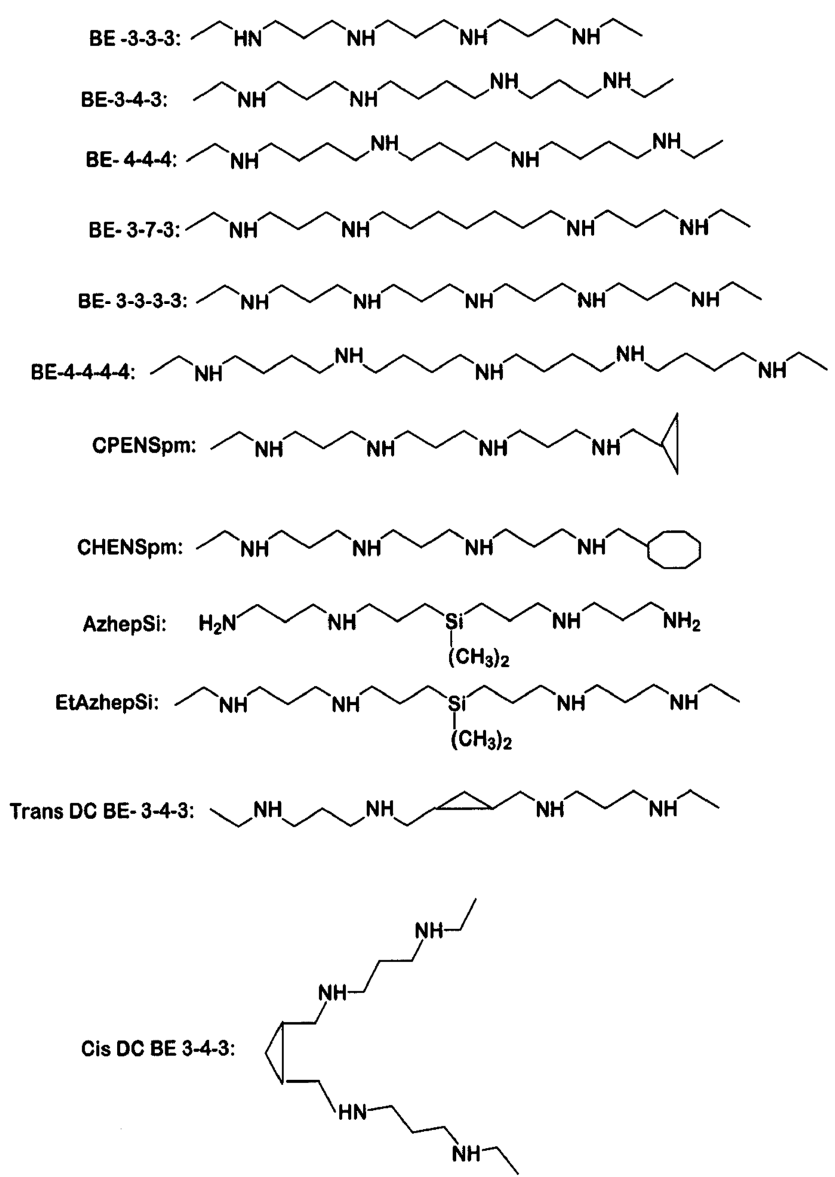
Figure 2. Chemical structures of polyamine analogs. Abbreviations are as follows; BE-3-3-3, N 1 , N 11 -bis(ethyl)norspermine (BENSpm or DENSpm); BE-3-4-3, N 1 , N 12 -bis(ethyl)spermine; BE-4-4-4, N 1 , N 14 -bis(ethyl)homospermine; BE-3-7-3, N 1 , N 15 -bis-[3-(ethylamino)propyl]-1-17-heptane diamine; BE-3-3-3-3, 1,15-bis(ethylamino)-4,8,12-triazapentadecane; BE-4-4-4-4, 1,19-bis(ethylamino)-5,10,15- triazanonadecane; CPENSpm, N 1 -ethyl- N 11 -(cyclopropyl)methyl-4,8-diazaundecane; CHENSpm, N 1 -ethyl- N 11 -(cycloheptyl)methyl)-4,8-diazaundecane; AzhepS1, bis(7-amino-4-azaheptyl) dimethyl- silane; EtAzhepSi, bis(7-ethylamino-4-azaheptyl)dimethylsilane; Trans DCBE-3-4-3, trans isomer of BE-3-4-3 with central 1,2, dimethylcyclopropyl residue; Cis DCBE-3-4-3, cis isomer of BE-3-4-3 with central 1,2-dimethylcyclopropyl residue.